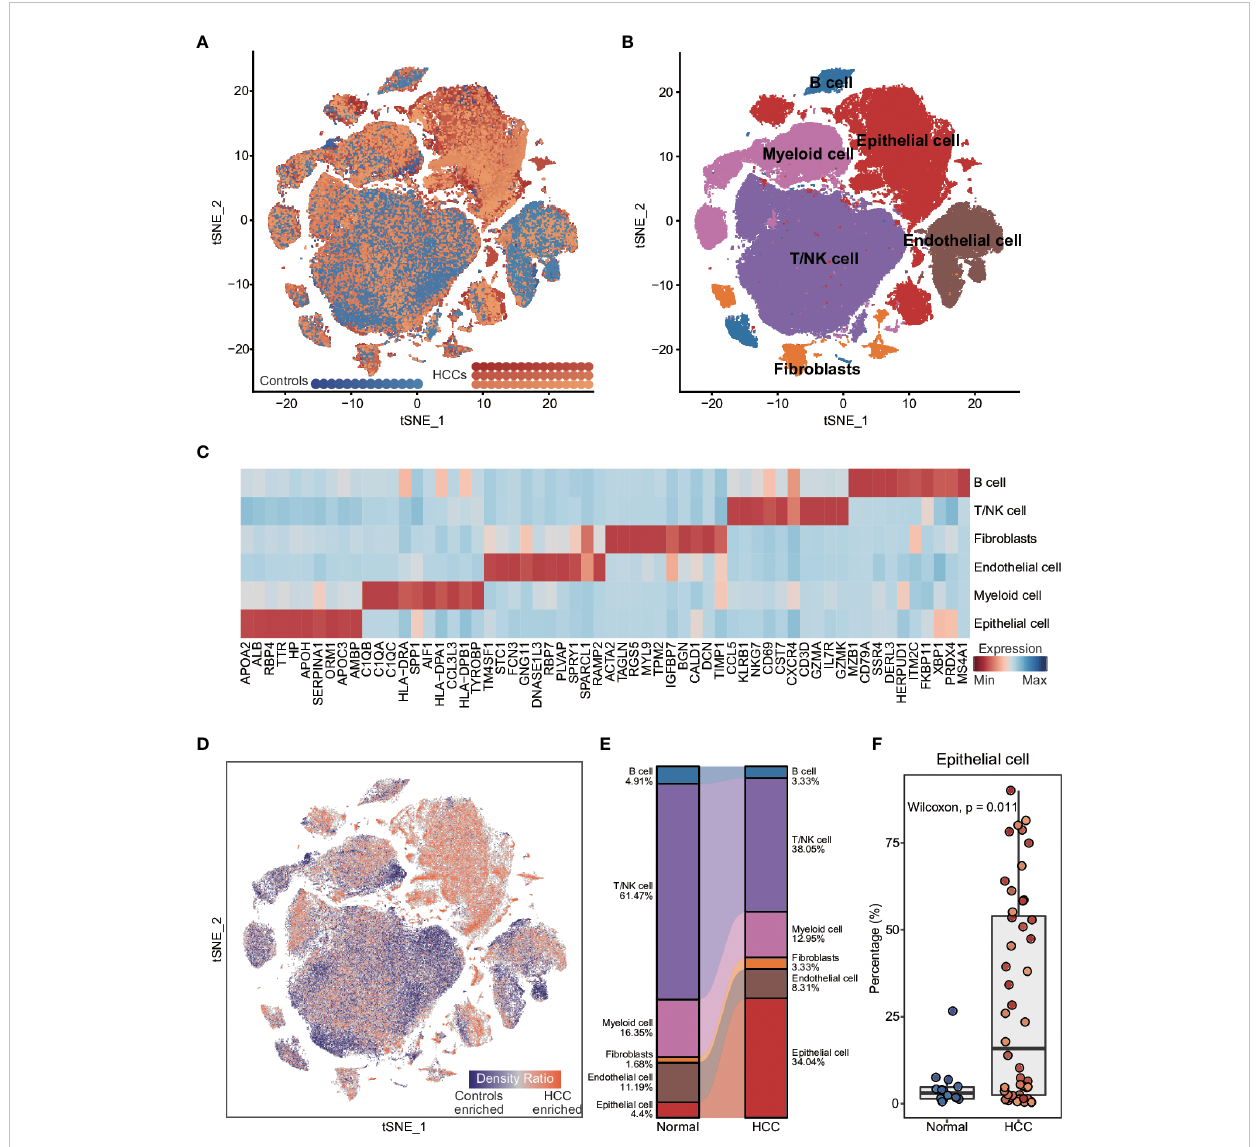
FIGURE 1 Comparison of cellular components between HCC patients and healthy controls at single-cell resolution (A) t-distributed stochastic neighbor embedding (t-SNE) visualization of 165,932 cells from 48 HCC patients and 14 healthy controls. (B) t-SNE visualization of cell types annotated by classical gene markers. (C) Heatmap showing the top ten cell type-speci fi c genes identi fi ed by the FindAllMarkers function. (D) Heatmap showing the distribution density of cells from HCC patients and healthy controls. The UMAP visualization is split into 200×200 bins. (E) Sankey plot showing the difference in cellular states between HCC patients and healthy controls. (F) Boxplot showing the proportion of cell types in HCC patients and healthy controls. Wilcoxon rank-sum test was used to measure the differences between two groups. Horizontal lines in the boxplots represent the median, the lower and upper hinges correspond to the fi rst and third quartiles, and the whiskers extend from the hinge up to 1.5 times the interquartile range from the